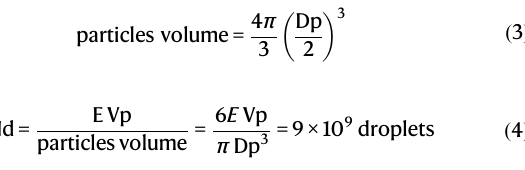
(<5 µ m) or into alveolar regions of lungs (<2 µ m). Volume Mean Diameter (VMD) presents the mean size of generated aerosols. c Fusion inhibitory activity of HRC4, measured before or after peptide nebulization, using β -gal complementation assay. Data represent the mean± SD of two independent experiments. d Antiviral activity of HRC4 measured prior and after nebuliza- tion, determined by IC 50 measurement using plaque reduction assay on Vero- hSLAM cells, and cytotoxicity assay, performed by assessing of cell viability 96h after addition of HRC4 by MTT assay. Data represent the mean± SD of of three independent experiments (Man-Whitney test, p = 0,8535). Source data are provided as a Source Data fi